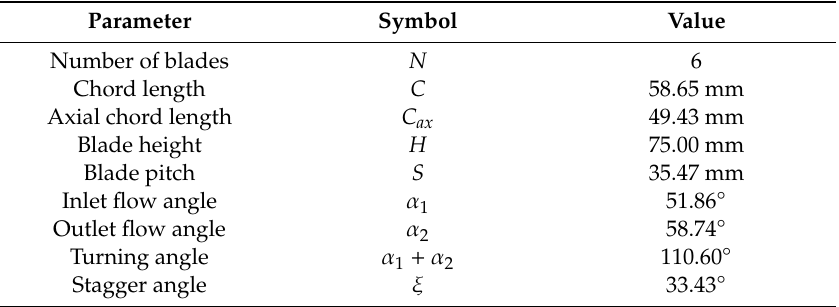
Figure 3. Test section of linear turbine cascade. Table 1. Specifications of linear turbine